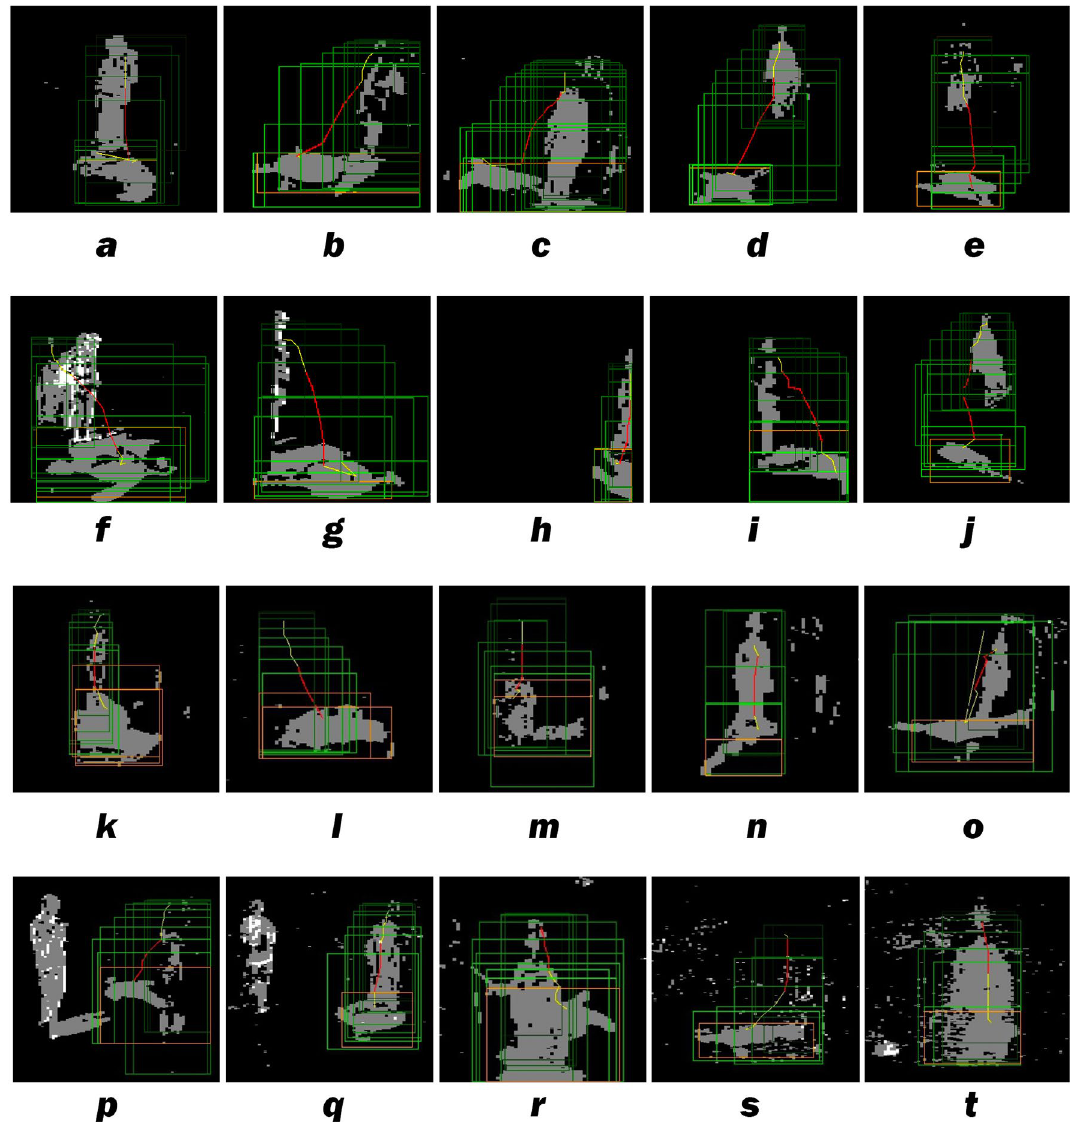
Figure 2. Our detection system used two very low-resolution cameras (so the system could process at high frame rates) to analyze fall patterns. Selected fall types under visible or infrared light captured by the system are displayed here. ( a ) Forward stumbling. ( b ) Sideway stumbling. ( c ) Backward stumbling. ( d ) Jumping down from a desk and falling. ( e ) Falling off a ladder. ( f ) Collapsing upon standing (i.e., Orthostasis). ( g ) Falling behind furniture (This situation is similar to a fall at the periphery of the camera viewing angle on the left). ( h ) Falling along the right edge of the viewing angle of the camera. ( i ) Falling partially out of the viewing angle of the camera. ( j ) Tumbling down stairs. ( k ) Forward fainting. ( l ) Sideway fainting. ( m ) Backward fainting. ( n ) Forward slipping. ( o ) Sideway slipping. ( p ) Backward stumbling in the presence of other people walking in the room. ( q ) Forward stumbling in the presence of other people walking in the room. ( r ) Forward stumbling with camera downward viewing angle greater than 45°. We crafted a rule to evaluate the inactive time. If the faller stays still for more than 10 s, the system will send the fall alarm. ( s ) Sideway stumbling behind a glass window covered by opened mini-blinds. ( t ) Forward stumbling behind a glass window covered by opened mini-blinds. Some of the short horizontal black lines in the figure represent the